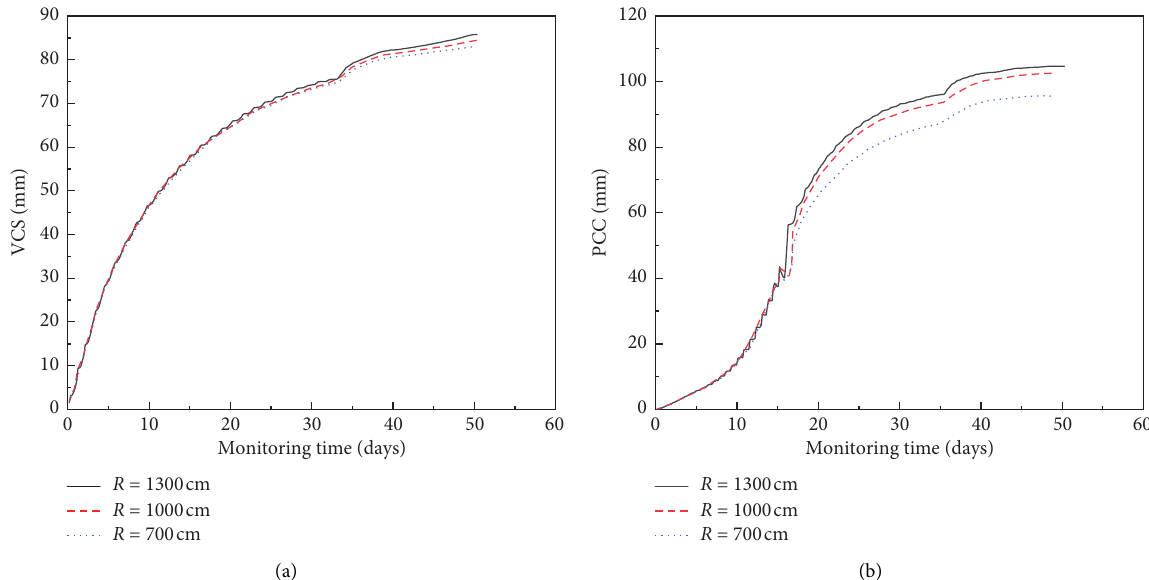
Figure 15: Deformation of the reinforced single-layer steel arch. (a) The VCS under different radii of the invert. (b) The PCC under different radii of the invert.